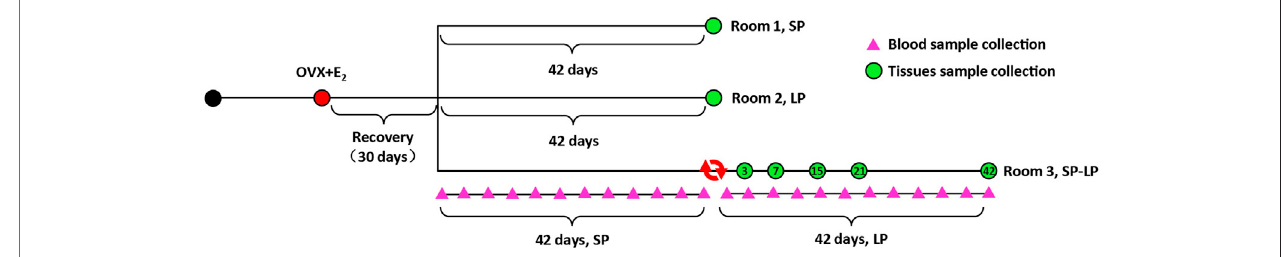
FIGURE1| Hormonepreparationandsamplecollectiontimeline.AllOVX+E 2 eweswereassignedtothreeexperimentalgroupsinthreerooms:shortphotoperiod (SP),longphotoperiod(LP),andshortphotoperiodtransfertolongphotoperiod(SP-LP).Atotalof24pinktrianglesrepresentthedayofbloodsamplecollectioninSP-LP groups, and seven green circles were the time of hypothalamus sample collection. In addition, the tissue and blood samples were collected at 8 a.m. and 2 p.m.,